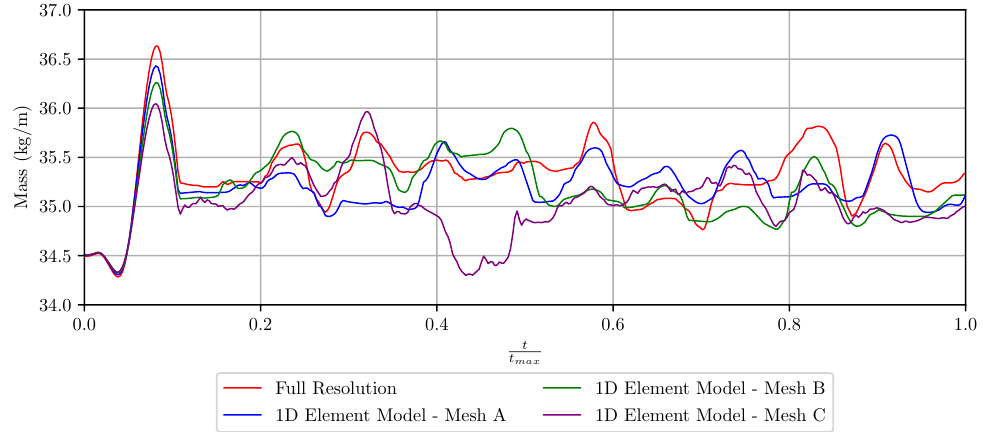
Figure 18. Mass of fluid on left half of tank of violent slosh test